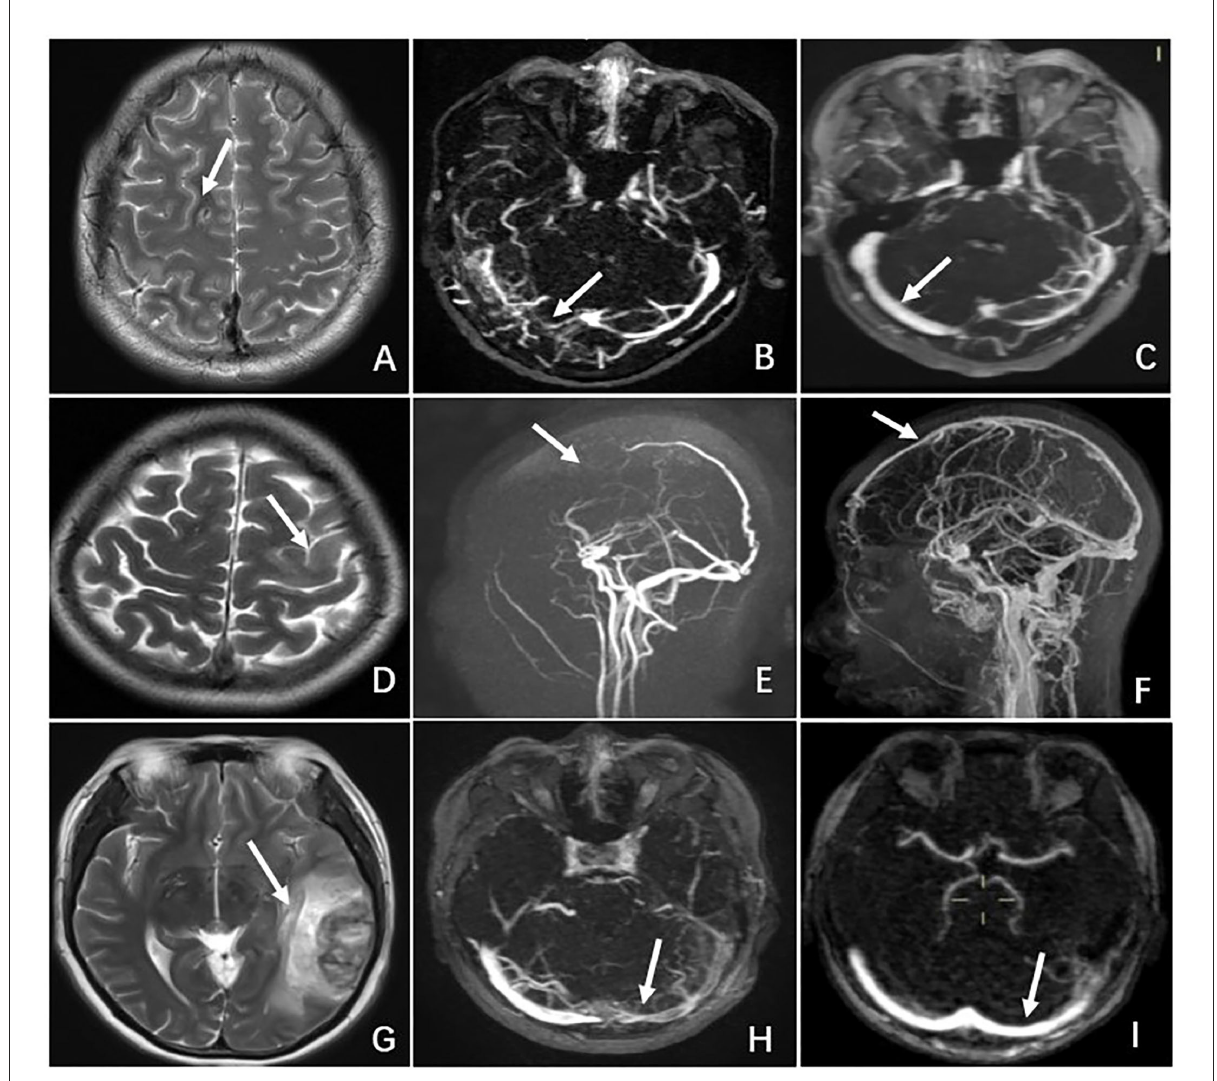
FIGURE2 Comparison of radiographic features of CVT between admission and discharge follow-up in 3 cases. Patient N2: (A) MRI on admission showing a hyperintense lesion in the right frontal lobe on T2-weighted MRI. (B) MRV on admission revealing occlusion of the right transverse sinus. (C) MRV on 6-month follow-up demonstrating recanalization of the right transverse sinus. Patient N3. (D) MRI on admission showing a hyperintense lesion in the left frontal lobe on T2-weighted MRI. (E) MRV on admission revealing occlusion of the superior sagittal sinus and cortical vein. (F) MRV on 12-month follow-up demonstrating recanalization of the superior sagittal sinus and cortical vein. Patient N5. (G) MRI on admission showing a hyper-and hypo-density lesion in the left temporal lobe on T2-weighted MRI. (H) MRV on admission revealing occlusion of the left transverse sinus. (I) MRV on 6-month follow-up demonstrating recanalization of the left transverse sinus.